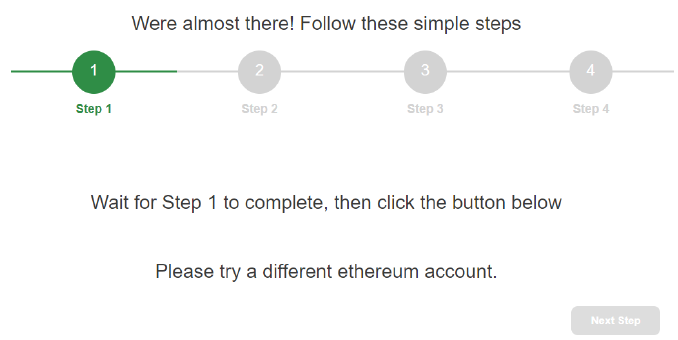
Figure 5. Selection of a IG -validated Ethereum account.